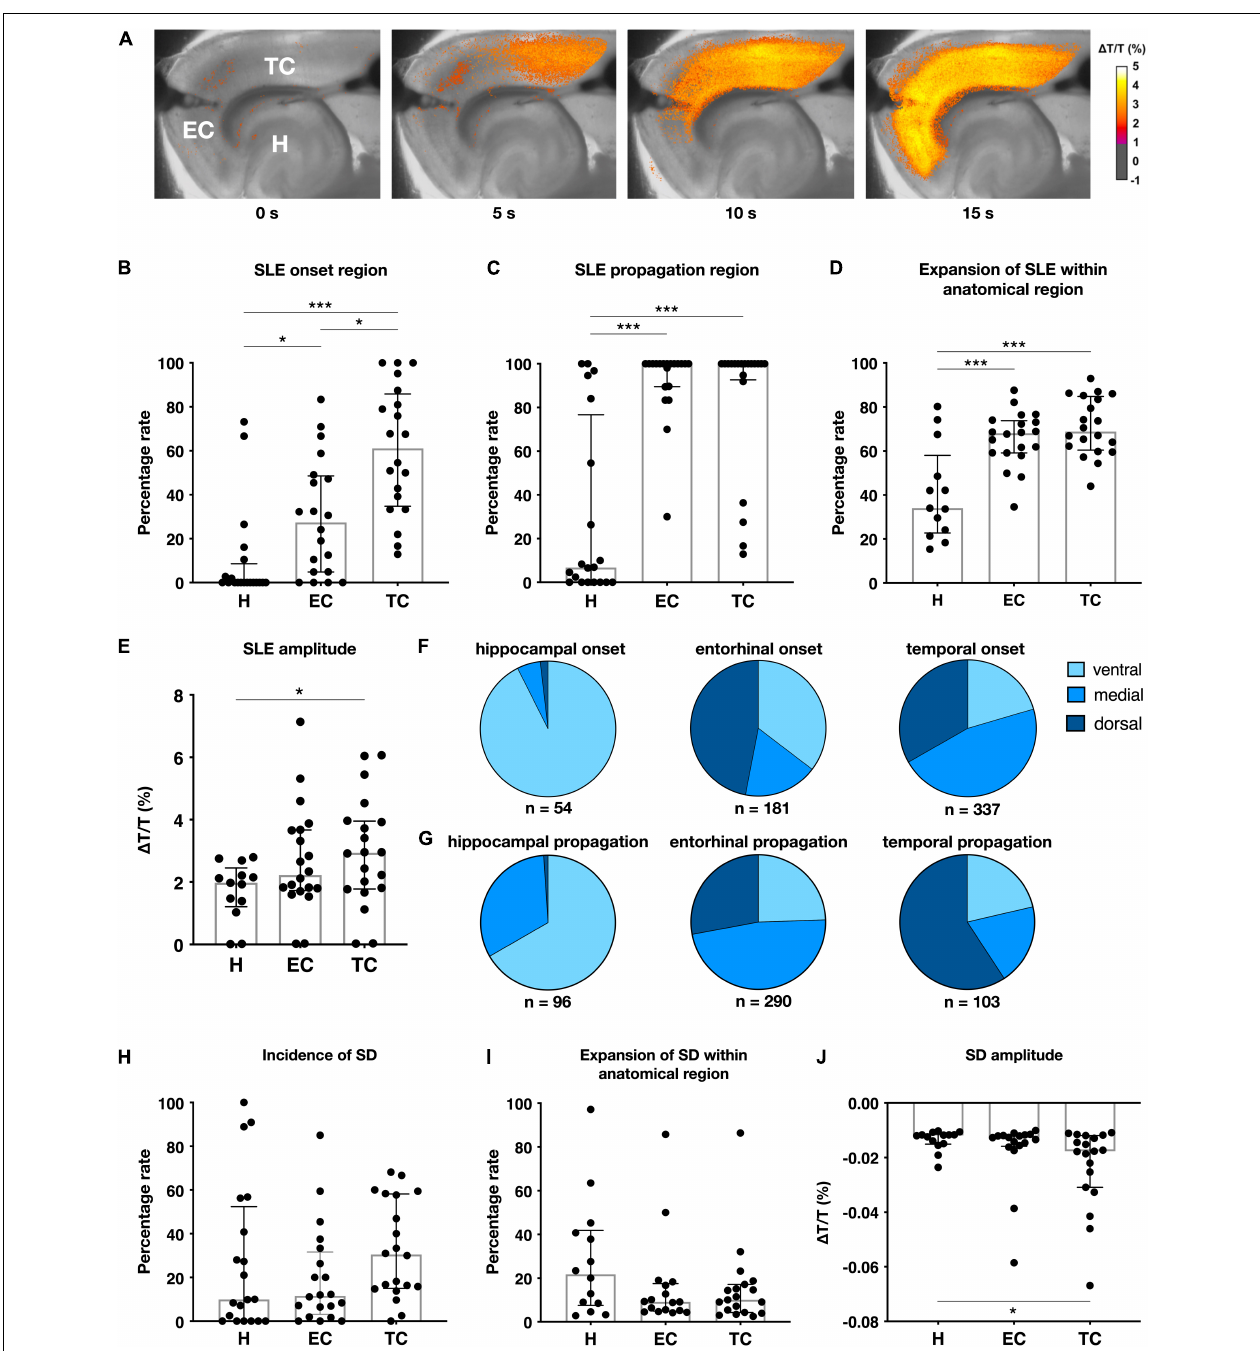
FIGURE 3 | Intrinsic optical imaging (IOS) in rat slices. (A) Color-coded SLE amplitude ( (cid:49) T / T ) over time during an exemplary SLE generated in the temporal cortex and propagating to the entorhinal cortex without further invading the hippocampal formation. Characteristics of SLEs (B–E) and spreading depolarizations (SDs) (H–J) measured by IOS in n = 20 slices (five slices for each 4-AP treatment duration of 1, 2, 3, or 4 h), scatter plots represent means of individually recorded slices, superimposed boxes show median ± interquartile range (* p < 0.05, *** p < 0.001). (F–G) SLE origin is influenced by the anatomical slice origin (dorsoventral axis) separated in ventral ( − 7.6 to − 6.8 mm ventrally from bregma), medial ( − 6.4 to − 5.6 mm) and dorsal ( − 5.2 to − 4.4 mm)